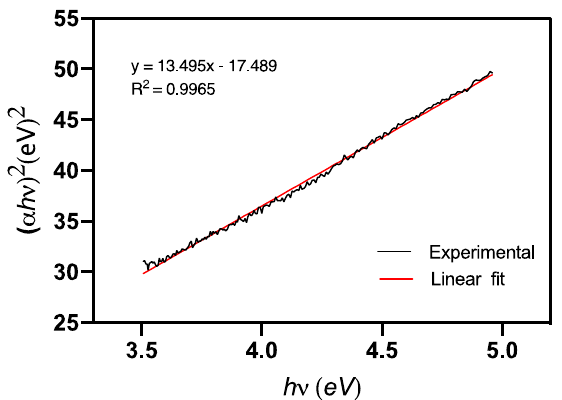
Figure 4. Tauc plot for shape-anisotropic Ca 0.25 Mg 0.75 Fe 2 O 4 ferrite nanoparticles (the red line corresponds to the linear fit).